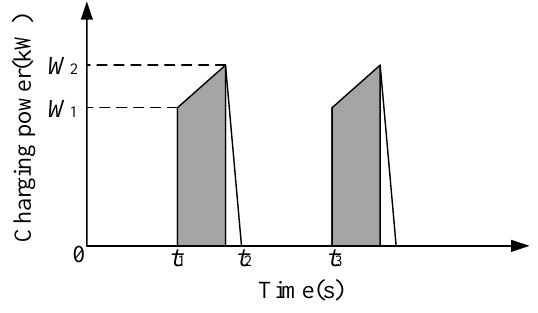
Figure 5. Traction load characteristics.